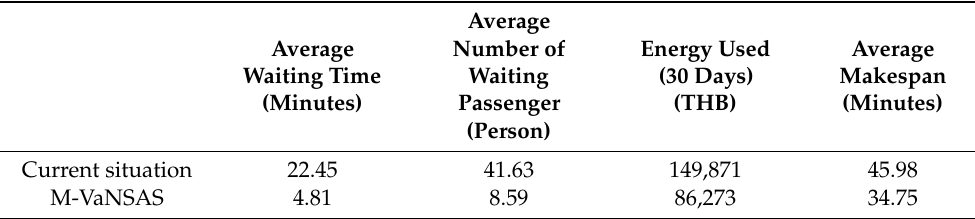
Table 10. Compared results of the current situation and the proposed